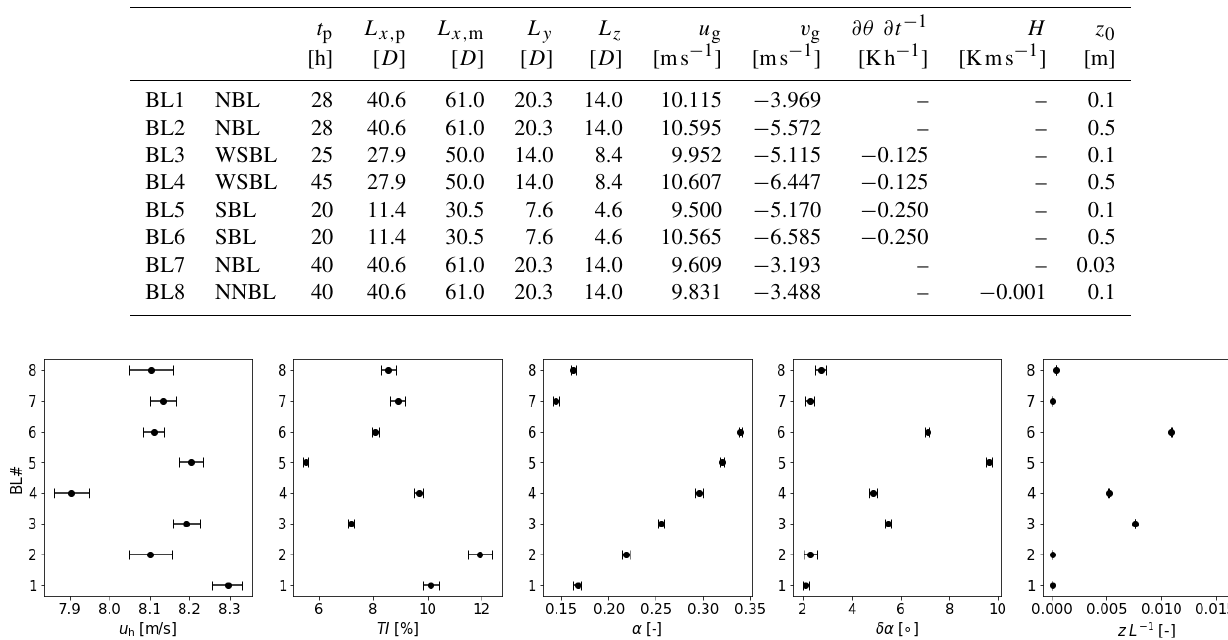
Figure 1. Summary of inflow parameters (60min averages), given as mean (dots) and standard deviation (whiskers) over the 15 main simulations performed in each BL (5 yaw angles times 3 pitch angles). Considered are wind speed ( u h ) and turbulence intensity at hub height (TI), wind shear ( α ) and veer ( δα ) over the rotor area, and the Obukhov stability parameter ( zL − 1 ) at z = 2.5m. Equations for these variables can be found in Table 3.